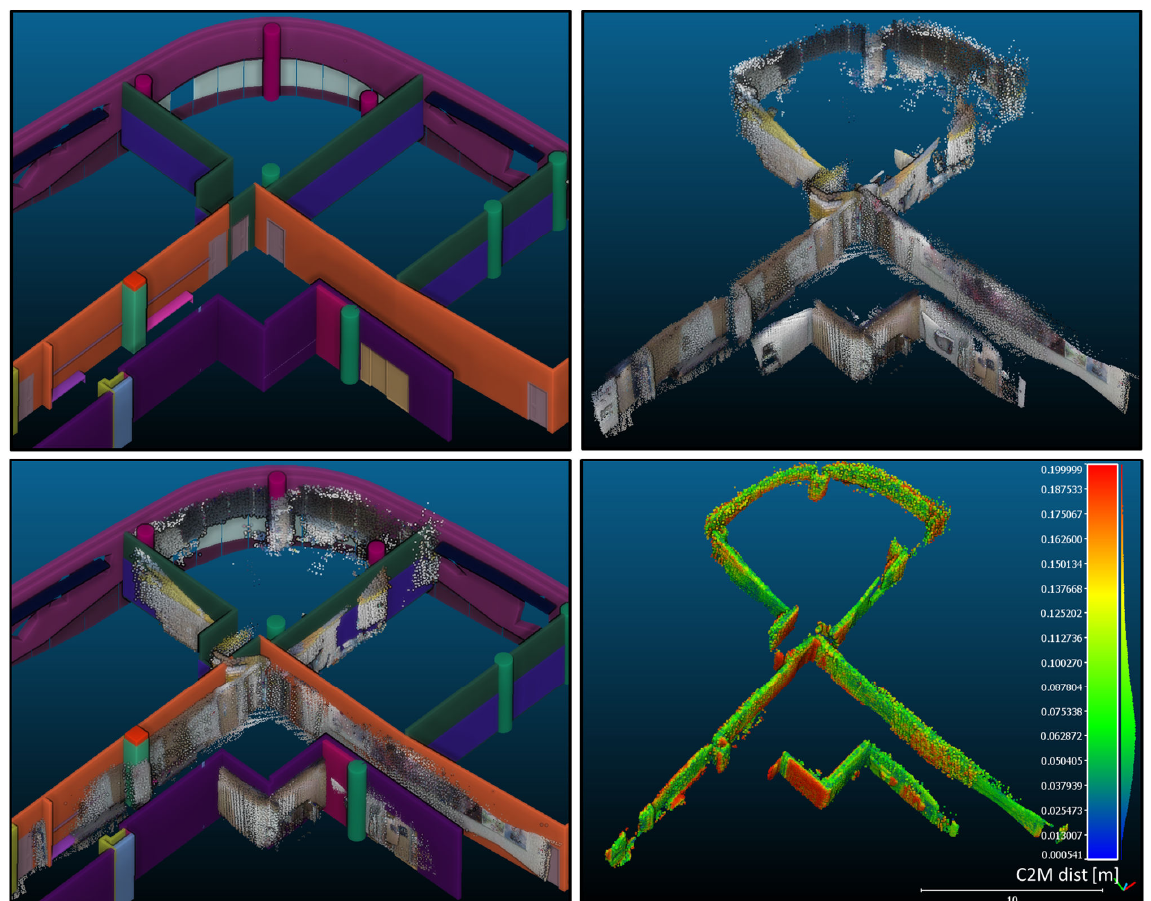
Figure 13: Top left) 3D Indoor model of the second floor of the study building. Top right) Point cloud captured using the integrated ViSP / RGB-D SLAM system. Bottom left) The collected point cloud overlaid on top of the 3D model. Bottom right) The Cloud to Mesh (C2M) distances (with 20 cm) between the collected point cloud and the 3D model.